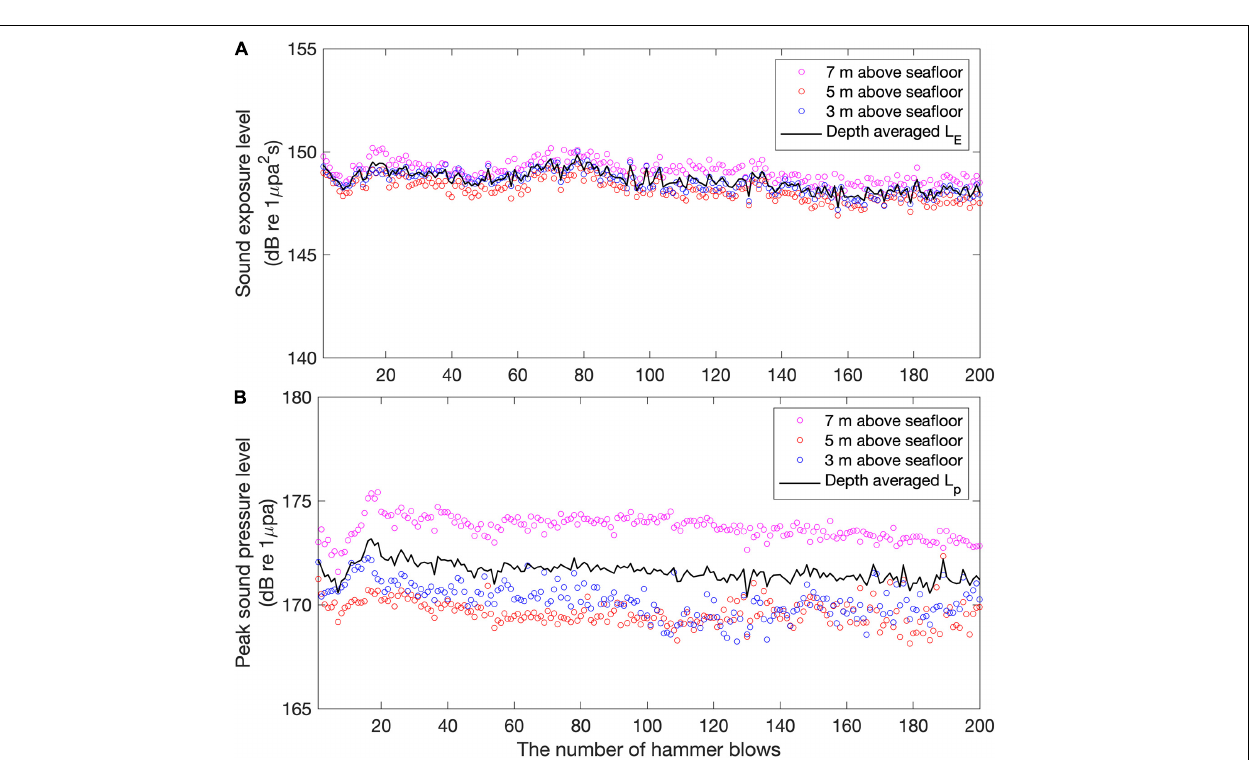
FIGURE 4 | Comparison of the spectrum levels between impact pile driving noise for pile B2 and ambient noise. The thick black line represents the depth-averaged ESD of pile driving noise averaged for 200 snapshots. The thin blue and red lines display the PSD of ambient noise measured before and after the pile driving